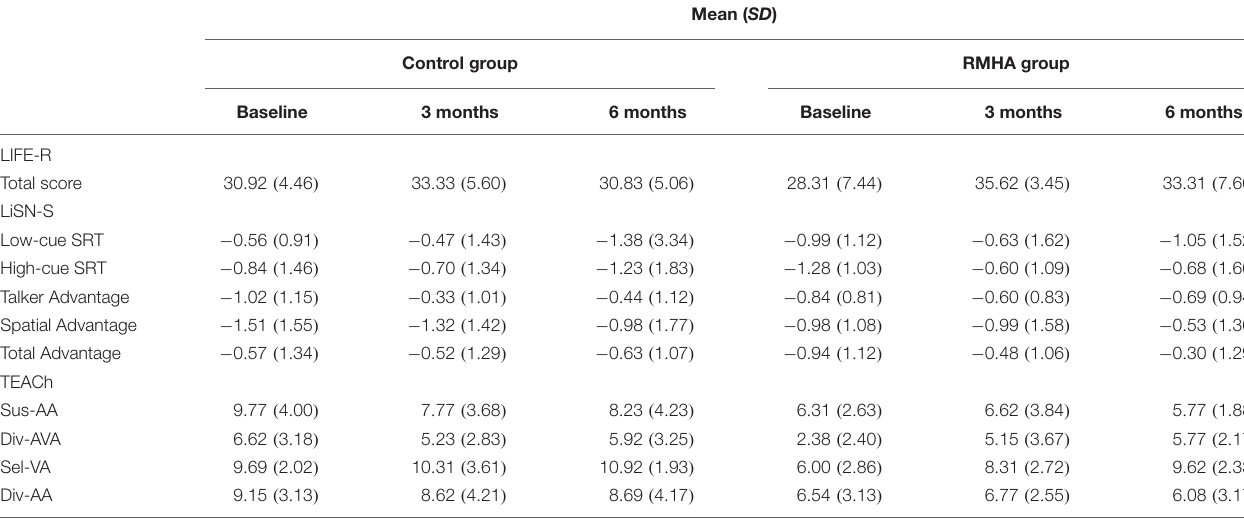
TABLE 4 | The mean scores and SDs of the LIFE-R Total Score, the LiSN-S scores, and the TEACh subtests, of the two groups at all three time-points.